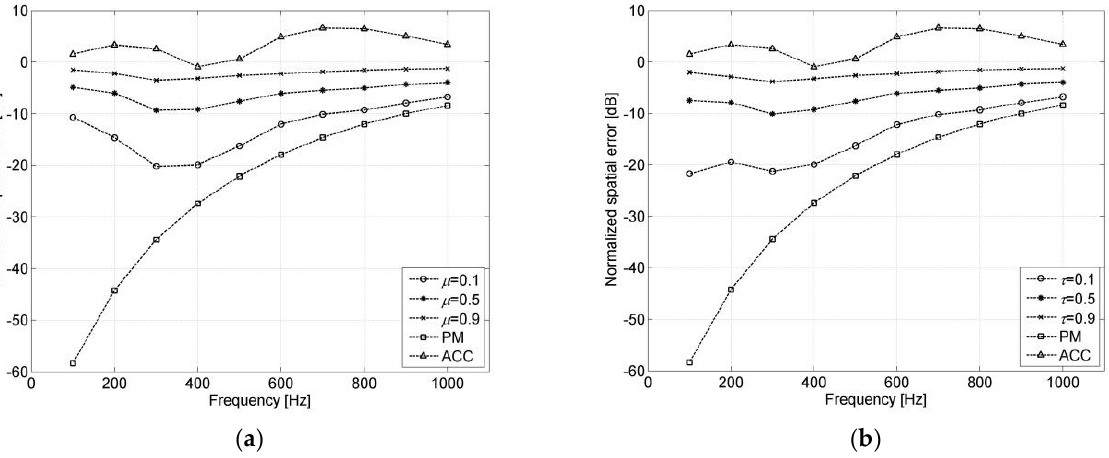
Figure 5. Normalized spatial average error of different methods for two-dimensional experiment. ( a ): PM method in bright zone, ACC method, the first proposed method with µ = 0.1, 0.5 and 0.9, respectively; ( b ): PM method in bright zone, ACC method, the second proposed method with τ = 0.1, 0.5 and 0.9, respectively.